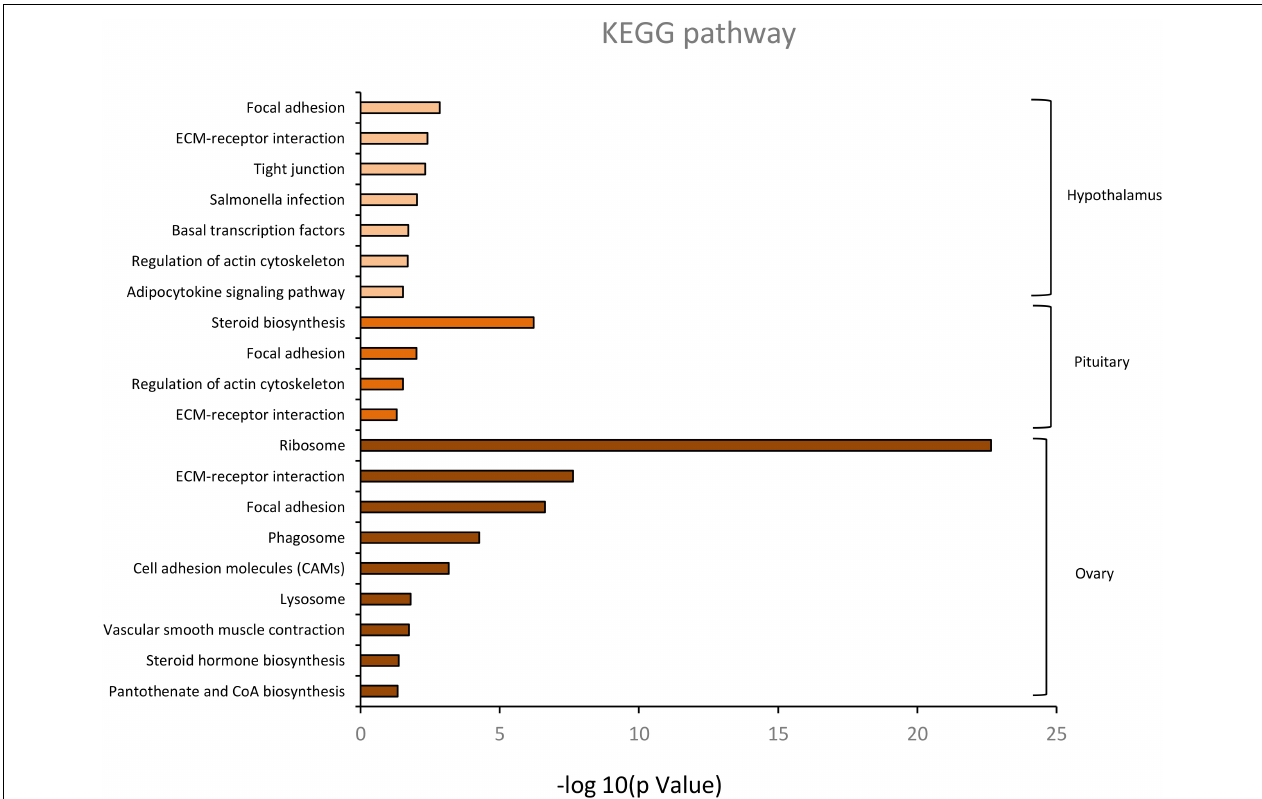
FIGURE 5 | The significant KEGG classification of differentially expressed genes in hypothalamus, pituitary and ovary ( p < 0.05).